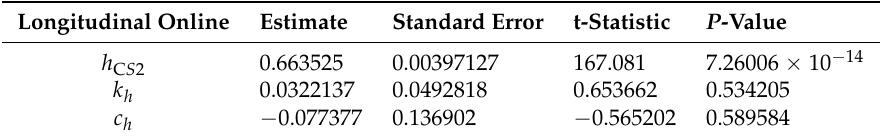
a a 2 + c + ( a 3 ) to the longitudinal color h ∗ fm ∗ O fm 2